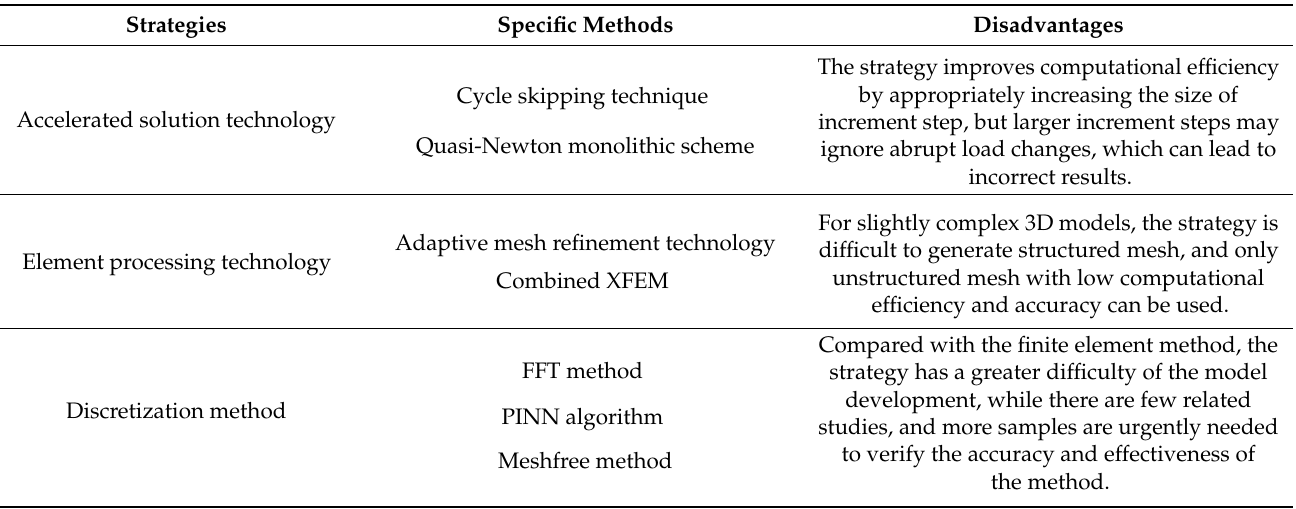
Table 1. Summary of the main performance improvement